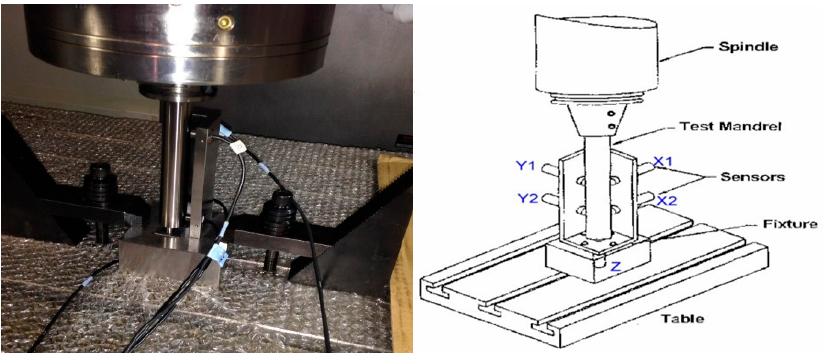
Figure 7. Measurement of displacements of working table in X , Y and Z directions.